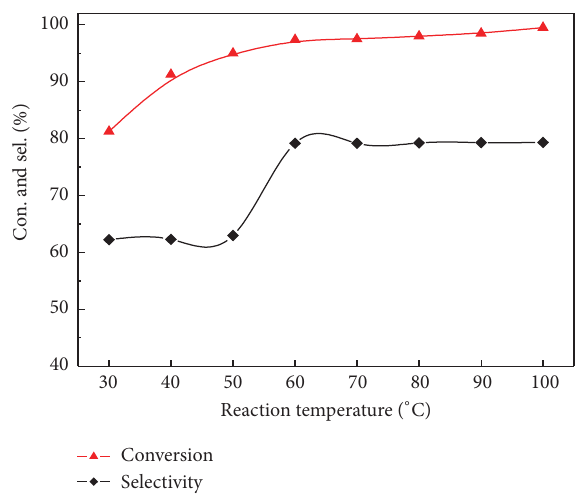
Figure 2: Hydrogen conversion and selectivity of hydrogen-oxygen reaction of Pd/Al 2 O 3 at different reaction